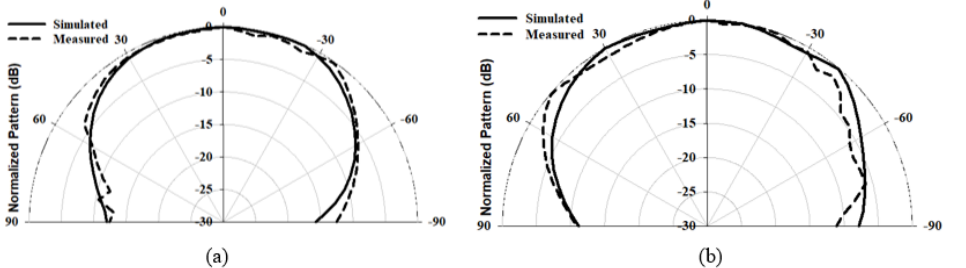
Figure 14. Radiation pattern of a hemispherical DRA with the added substrate at 26 GHz ( a ) φ = 0 ◦ ( b ) φ = 90 ◦